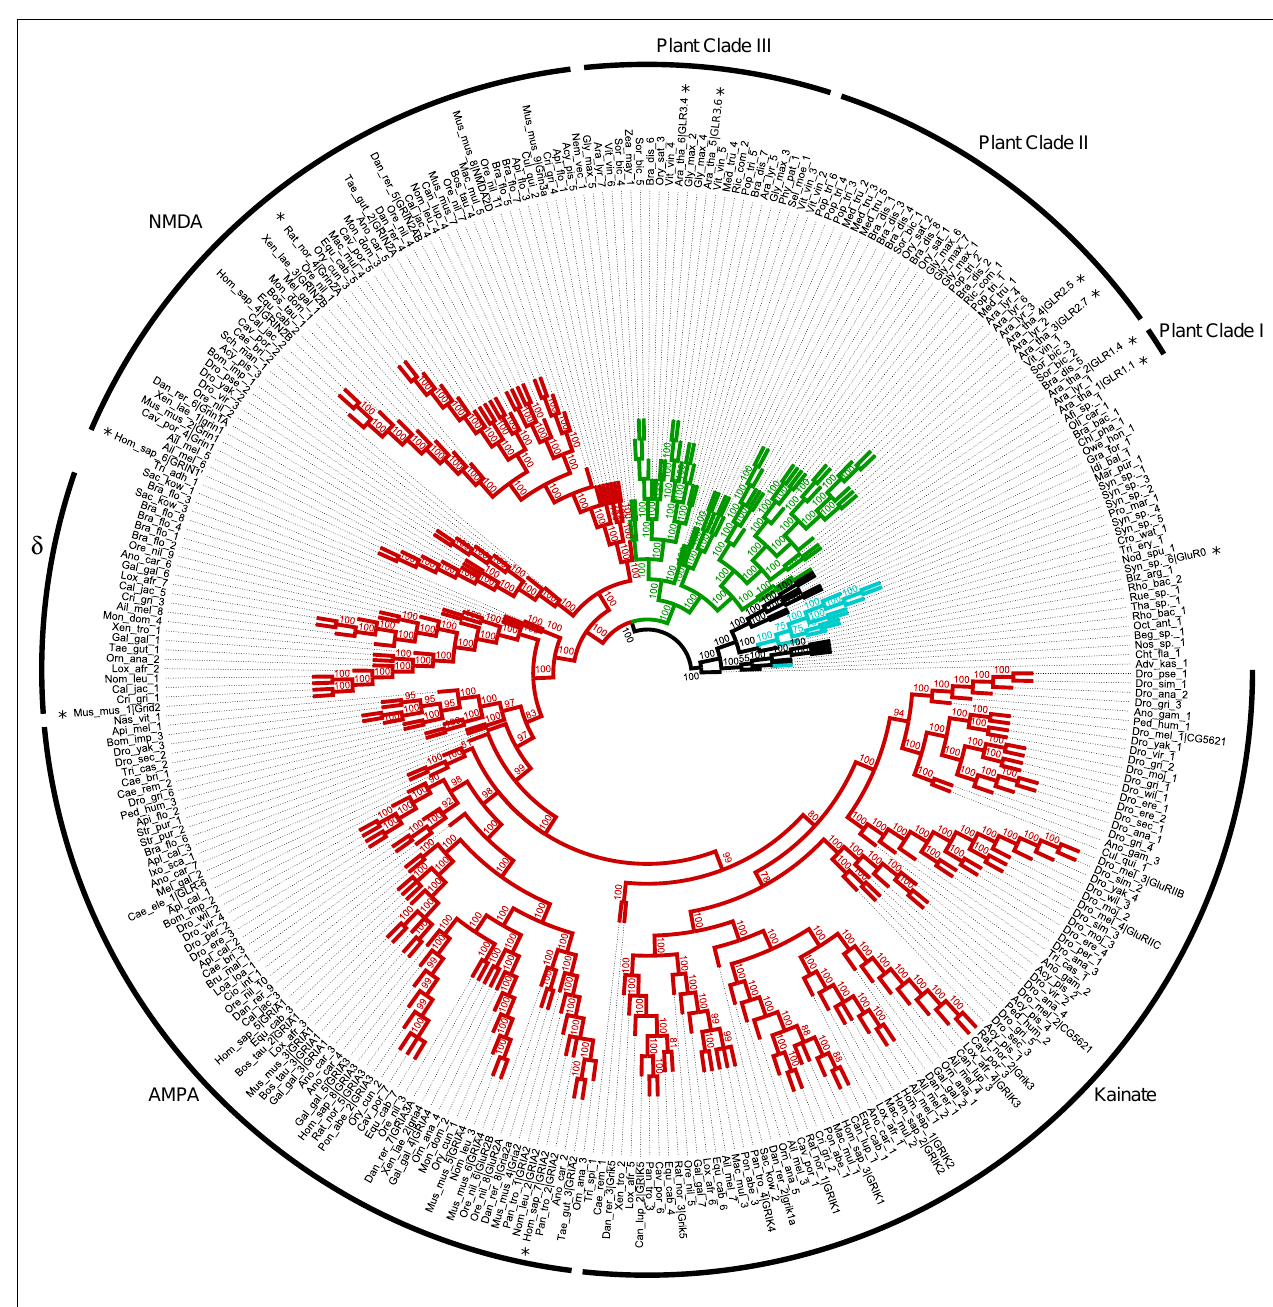
subfamilies of mammalian receptors are also indicated. Accession numbers of proteins included in the tree are provided in theTable S2 in Supplemental Material. Sequences represented in Figure 4 are marked with